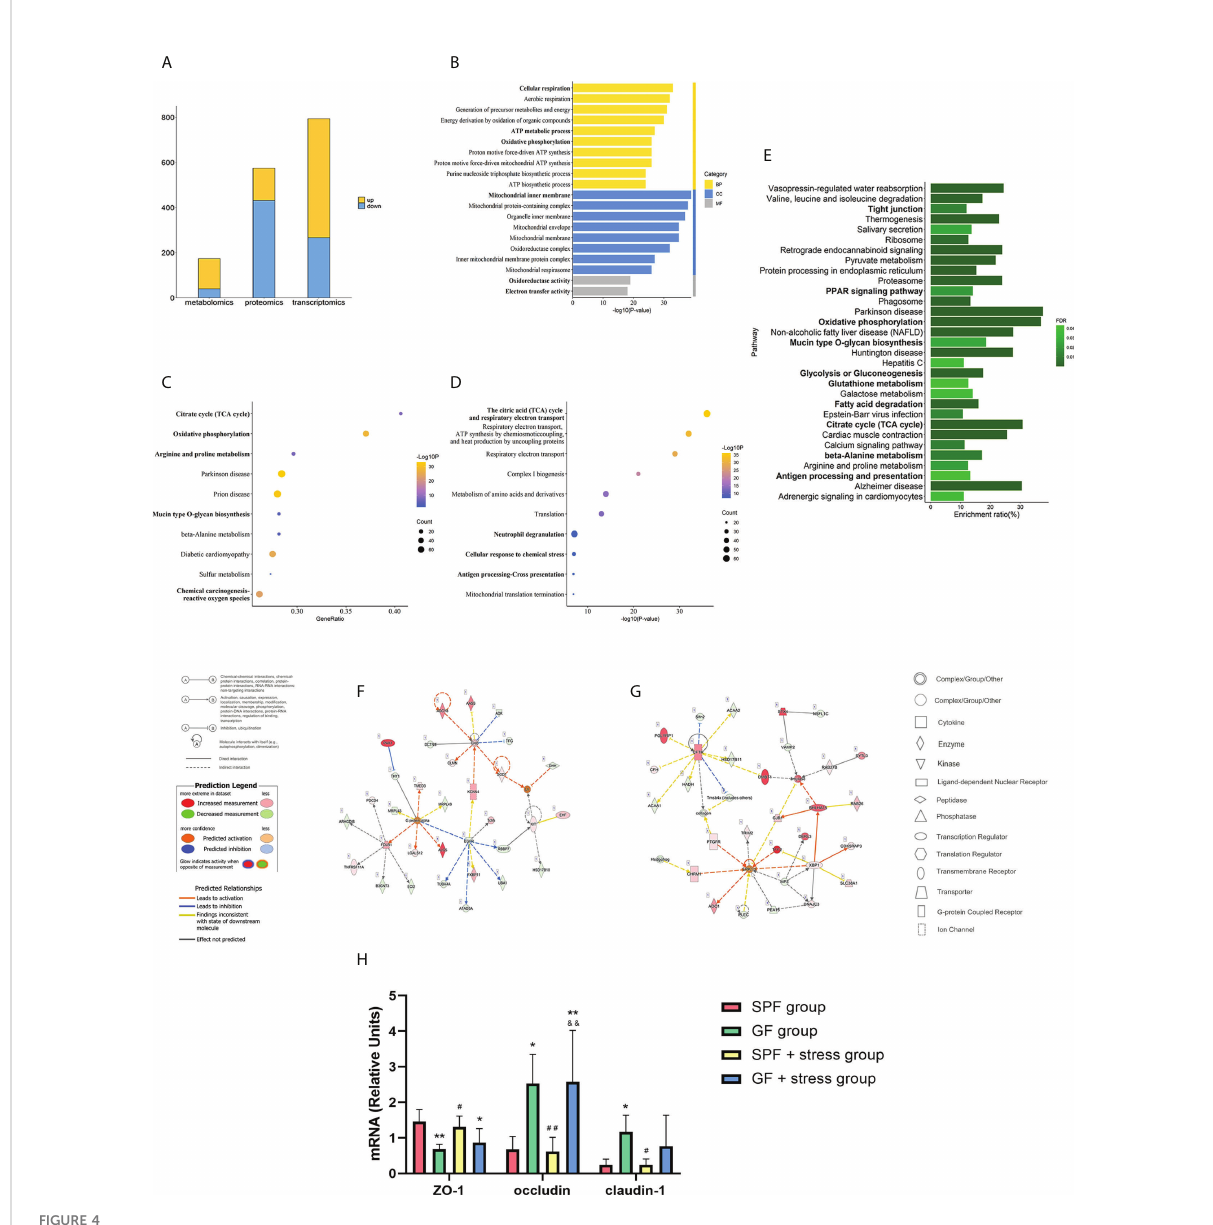
FIGURE 4 Multi-omics analysis suggests that chronic stress may enhance the regulation of microbiota on oral homeostasis. (A) Histogram showing the number of differentially expressed molecules during the tongues of SPF and GF mice in multi-omics analysis under chronic stress. (B – D) GO/ KEGG/Reactome enrichment analysis of combined transcriptomics and proteomics of the tongue in SPF and GF mice under chronic stress. (E) KEGG pathway enrichment analysis of multi-omics of the tongue in SPF and GF mice under chronic stress. (F, G) IPA of multi-omics of the tongue in SPF and GF mice under chronic stress. (H) The bar graph of mRNA expression representing oral epithelial permeability in four groups of mice. The bold fonts represent the molecules of particular interest in the enrichment pathway. Scale bar: 50 m m. The experiment of qPCR was performed at least three times independently. *p < 0.05 vs SPF group; **p < 0.01 vs SPF group; ***p < 0.001 vs SPF group; #p <0.05 vs GF group; ##p < 0.01 vs GF group; ###p < 0.001 vs GF group; &p < 0.05 vs SPF + stress group; &&p < 0.01 vs SPF + stress group; &&&p < 0.001 vs SPF + stress